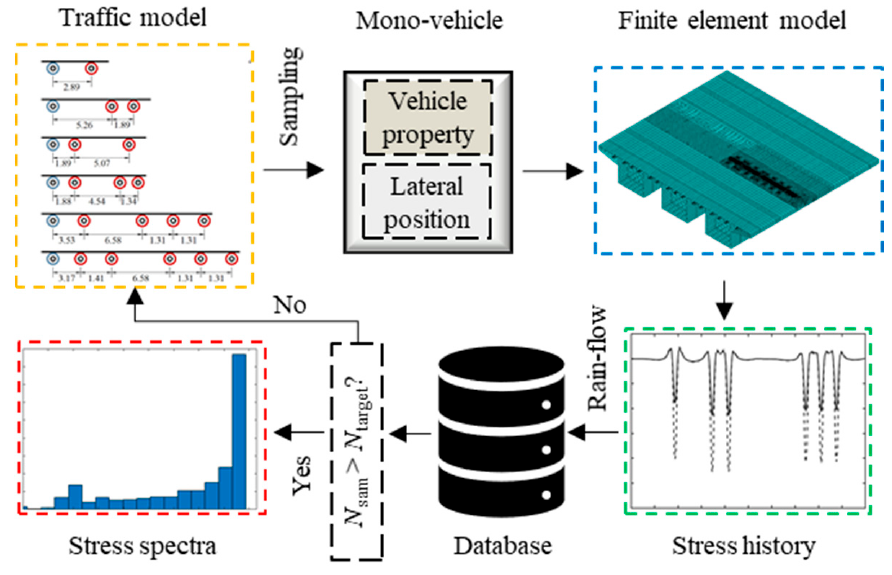
Figure 13. Procedures for stress spectra derivation.